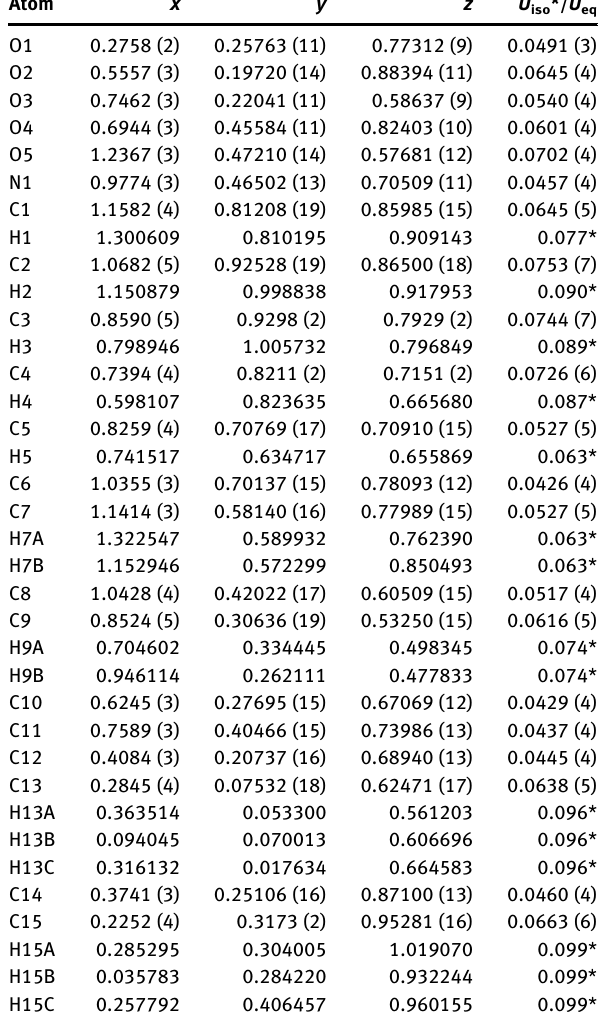
Table  : Fractional atomic coordinates and isotropic or equivalent isotropic displacement parameters (Å 